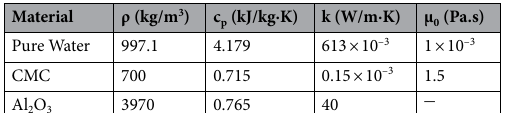
Table 1. The thermophysical properties of the non-Newtonian base fluid and nanoparticles 59,60 .